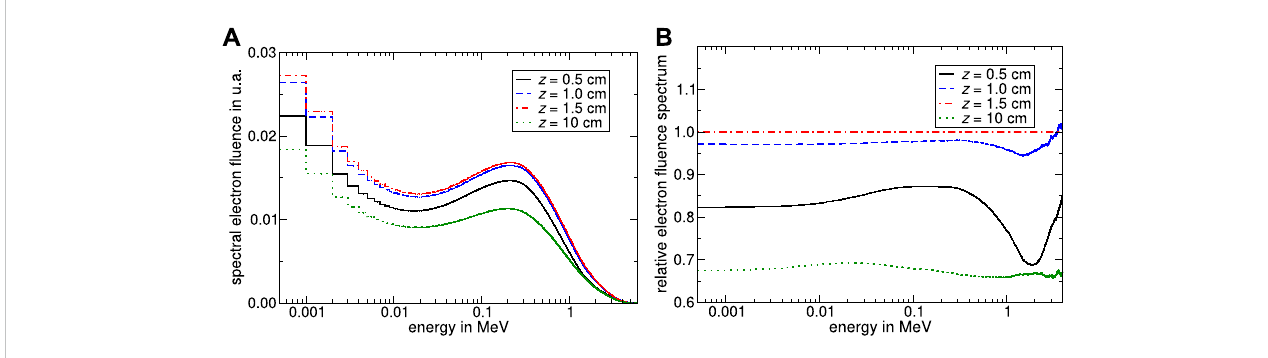
FIGURE 4 MonteCarlocalculatedspectralsecondaryelectron fl uenceinwateratdifferentdepths.Thewaterphantomwasirradiatedwitha6 MVlinearaccelerator x-ray spectrum taken from Mohan[26]from acollimated point source with a fi eld size of 10 cm × 10 cm. Sub fi gure (A) shows the secondary electron fl uence as a function of energy. Panel (B) shows the relative secondary electron fl uence spectrum normalized to the spectral electron fl uence at 1.5 cm water depth. The uncertainty varies depending on energy in a range of 0.005% – 0.5% for panel (A) and 0.01% – 1.2% for panel (B) .